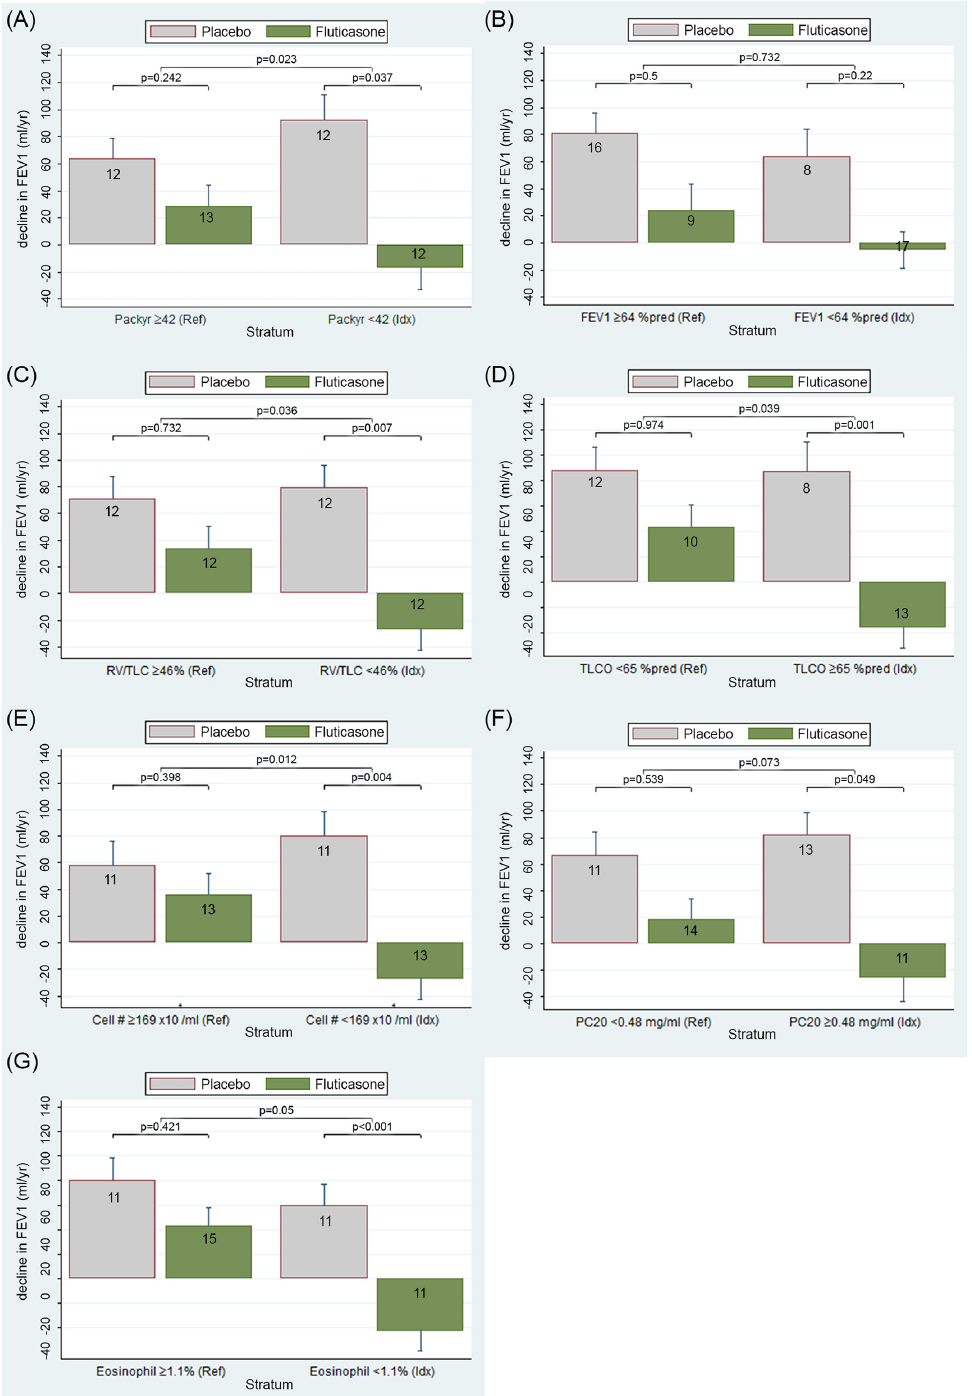
Fig 2. Long-term predictors of FEV 1 decline by fluticasone treatment. (A) Prediction by packyears smoking of the decline of FEV 1 by 2.5 year fluticasone treatment (ml) and placebo, stratified by median values of the predictor by 30 months treatment with fluticasone compared to placebo. # Index category (Idx) is defined relative to median value, and represents the more favourable outcome by fluticasone. Reference category (Ref) is complementary. The group numbers of the patients are mentioned in each graph. For example: Fig 2A shows the decline in FEV 1 in ml/yr on the Y axis for patients with many pack years and patients with few pack years with fluticasone or placebo treatment, respectively, on the X axis. All P values are based on the results of the linear mixed effects model. The treatment * time interaction term corresponding to the difference in decline in FEV 1 between fluticasone and placebo in the low pack year